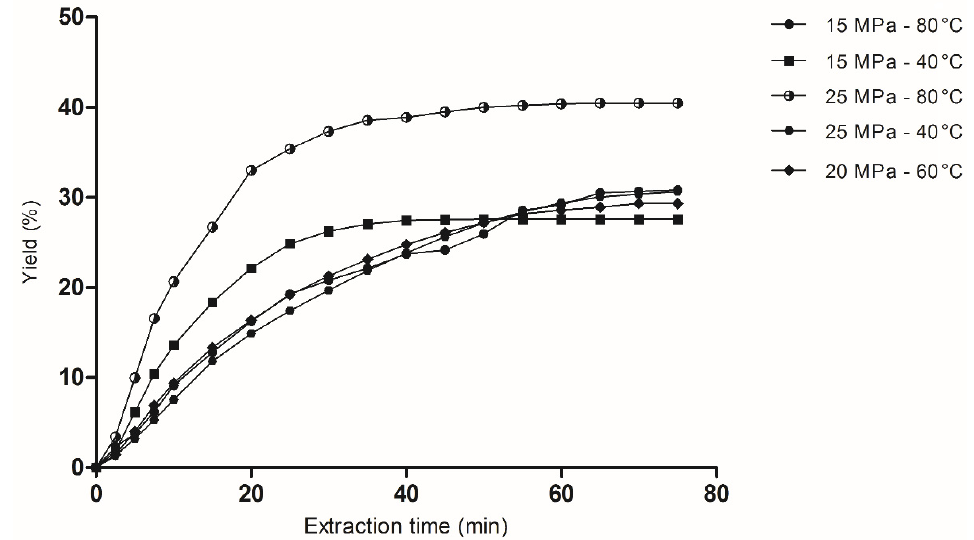
Figure 1. Overall extraction curves for dried fermented soybean using scCO 2 + EtOH as a solvent. The lowest yield (27.56%) can be observed when using the lowest pressure (15 MPa) and highest temperature (80 ◦ C). Pressure is the parameter that positively influences the yield of scCO 2 , so that the increase reflects the increases in density, viscosity, and the solvation power of CO 2 [26,27] . Therefore, the lower yield is probably a reflection of the during extraction